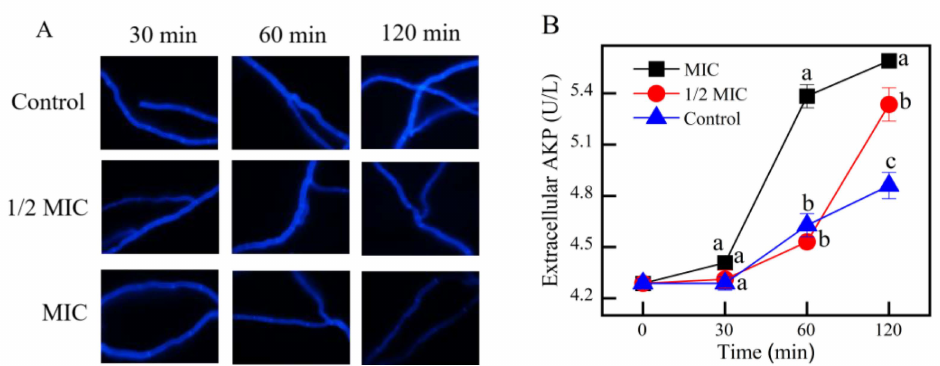
Figure 6. The effect of γ -CDCL on the cell walls of P. digitatum. ( A ) CFW staining images of P. digitatum mycelia treated with γ -CDCL (Control; 1/2 × MIC; 1 × MIC) for 30, 60, 120 min; ( B ) The extracellular AKP activity of P. digitatum . Data are expressed as the means ± standard deviation of pooled data ( n = 3, p < 0.05). γ -CDCL, cinnamaldehyde/ γ -cyclodextrin inclusion complex; CFW, calcofluor white; AKP, alkaline phosphatase; MIC, minimum inhibitory concentration. Dissimilar lowercase letters in the histogram express the statistical significance among different treatments at the same